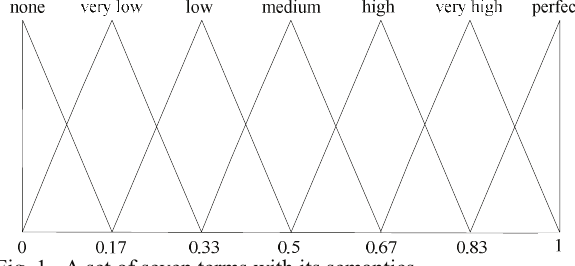
Fig. 1. A set of seven terms with its